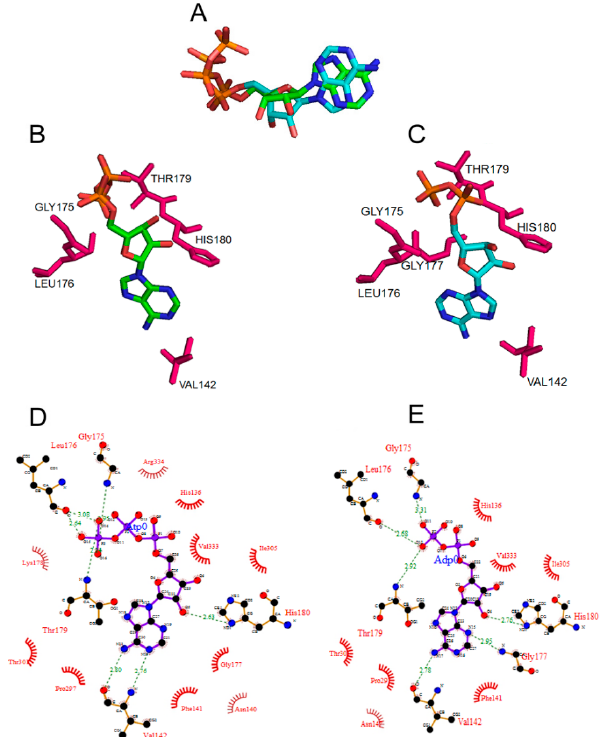
Figure 1. The amino acid residues forming the nucleotide-binding pocket of DnaA protein bound to ADP and ATP adopt different confirmations. ( A ) Overlap of the conformations of ADP and ATP present in the modeled E. coli DnaA protein in their bound state; ( B , C ) Amino acid residues interacting with the ATP and ADP. Figures were generated using PYMOL software; ( D , E ) Molecular interactions of residues in the nucleotide binding pocket with bound ATP ( D ) or ADP ( E ), hydrogen bond interactions are indicated as dashed lines in green and the van der Waals interaction are indicated as half-circles in red wire diagrams. The numbers indicate the hydrogen bonding distance between the atoms in Å units. The Figures were generated using PDBSum.